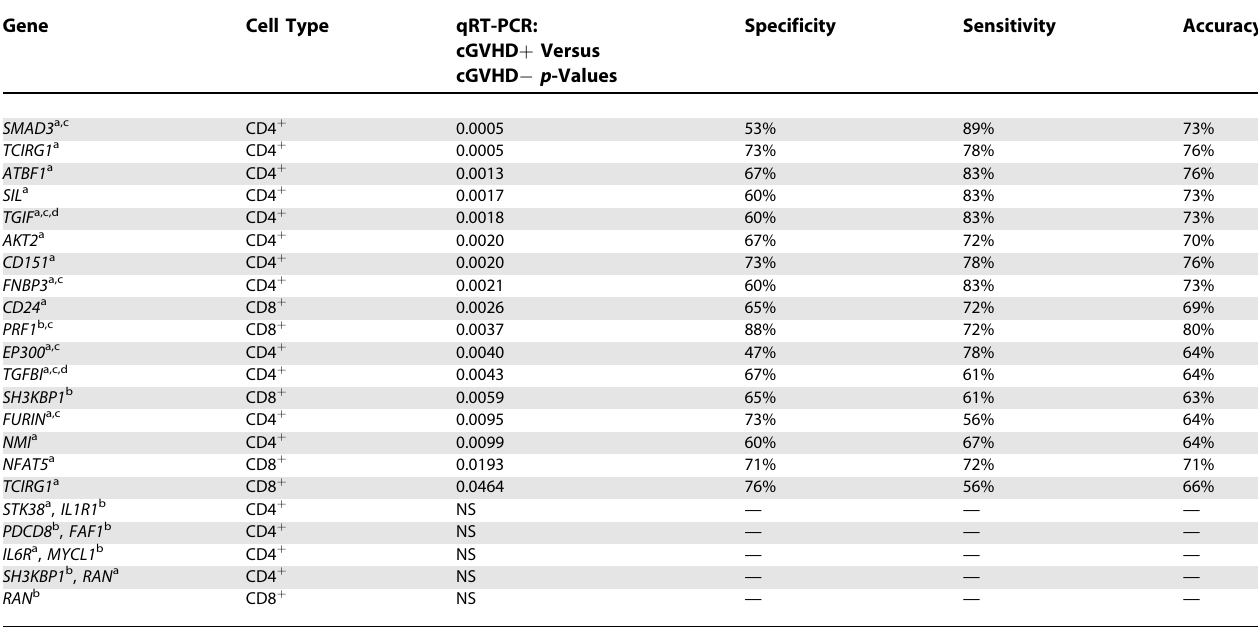
Table 2. qRT-PCR Analyses of GVHD-Predictive Genes Gene Cell Type qRT-PCR: